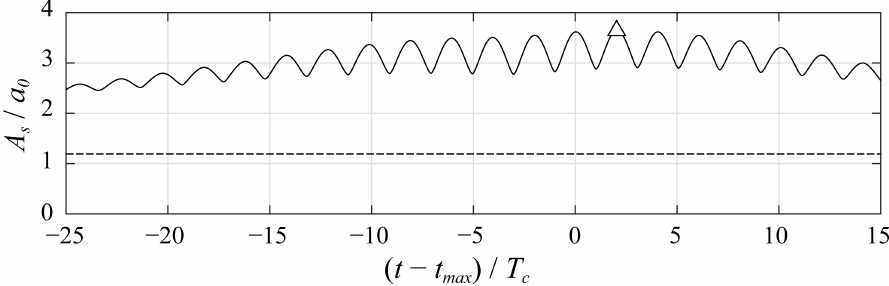
Figure 10. Temporal evolution of the amplitude sum A s of the modulated wave train with a 0 k c = 0.105 at approximately the time of the maximum crest height ( t = t max ) in the HOSM simulation. The dashed line represents the initial value, and the triangle indicates the maximum